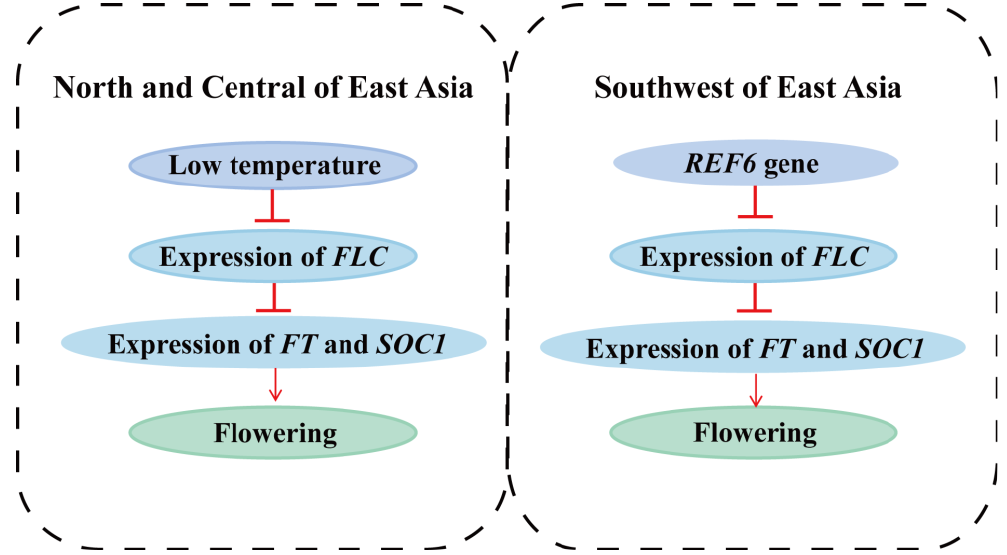
Figure 6. REF6 gene controlling flowering time. Inhibitory action is represented by a horizontal line under a vertical line, promoting action is represented by an arrow of a solid line. FT and SOC1 promote flowering, but both are inhibited by FLC . In northern and central East Asia, the expression of FLC in P. davidiana is inhibited in winter because of low temperatures and thus controls flowering time, while the temperature in southwestern East Asia is not sufficiently low to inhibit FLC expression. Expression of the REF6 gene has an important inhibitory effect on the FLC gene, and thus plays a pivotal role in promoting flowering.